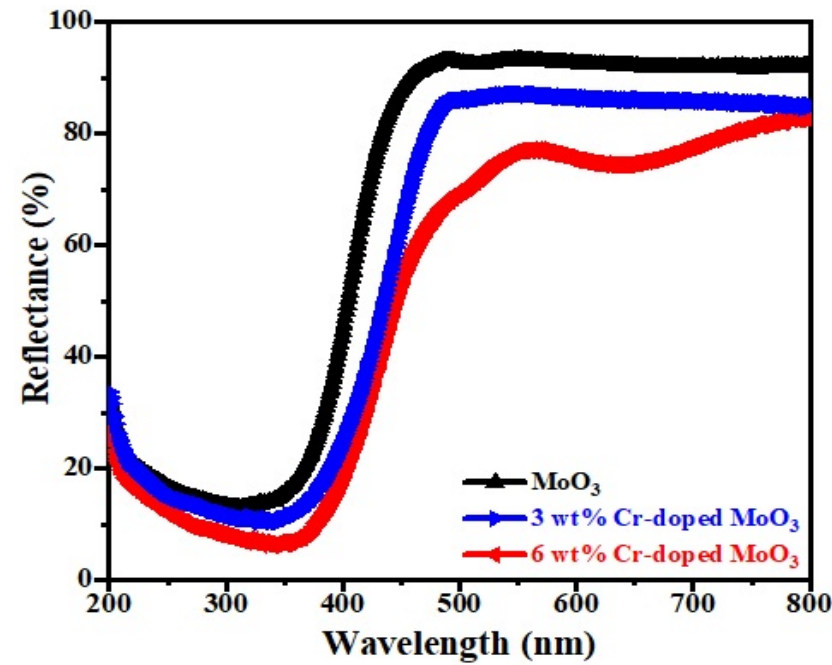
Figure 5. DRS spectra of un-doped and Cr-doped MoO 3 samples.